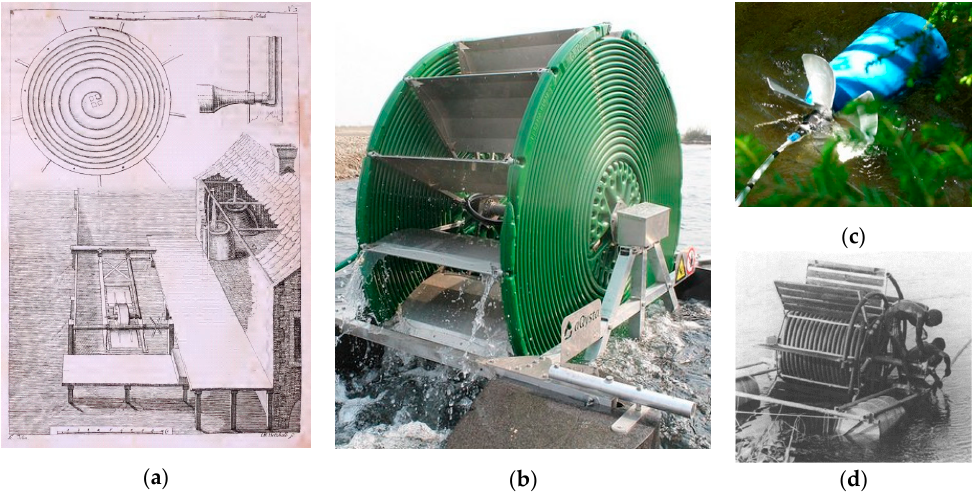
Figure 2. Di ff erent types of manometric pumps: ( a ) First ever known hydro-powered spiral pump Figure 2. Different types of manometric pumps: ( a ) First ever known hydro ‐ powered spiral pump (HSP) from 1746 in Zurich [52]. CC BY-NC 3.0; ( b ) Modern HSP—aQysta’s Barsha pump [53]. © (HSP) from 1746 in Zurich [52]. CC BY ‐ NC 3.0; ( b ) Modern HSP—aQysta’s Barsha pump [53]. © USAID USAID (https: // securingwaterforfood.org / innovator-news / hydro-powered-pump-o ff ers-eco-friendly- irrigation-solution). Croppedfromtheoriginal; ( c )Hydro-poweredhelixpump(HHP)[54]. Reproduced with permission from Rife Hydraulic. © Rife Hydraulic Engine Manufacturing Company (https: // www. riferam.com / pumps.html); ( d ) Hydro-powered coil pump (HCP) [51]. Reproduced with